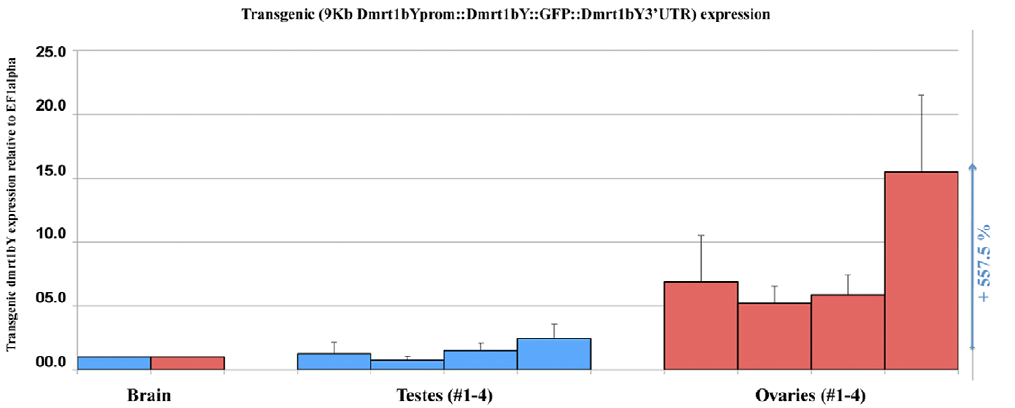
Figure 5. In vivo quantification of the 9KbDmrt1bYpromoter activity in transgenic fish. Real-time PCR quantification of the 9KbDmrt1bYpromoter activity in two different gonadal backgrounds either expressing dmrt1a (testes, # 1–4) or not (ovaries, # 1–4) reveals higher activity ( + 557.5% expression) in absence of dmrt1a expression. Dmrt1bY expression is relative to elongation factor 1 alpha (ef1 alpha) and normalised to brain background expression (set to